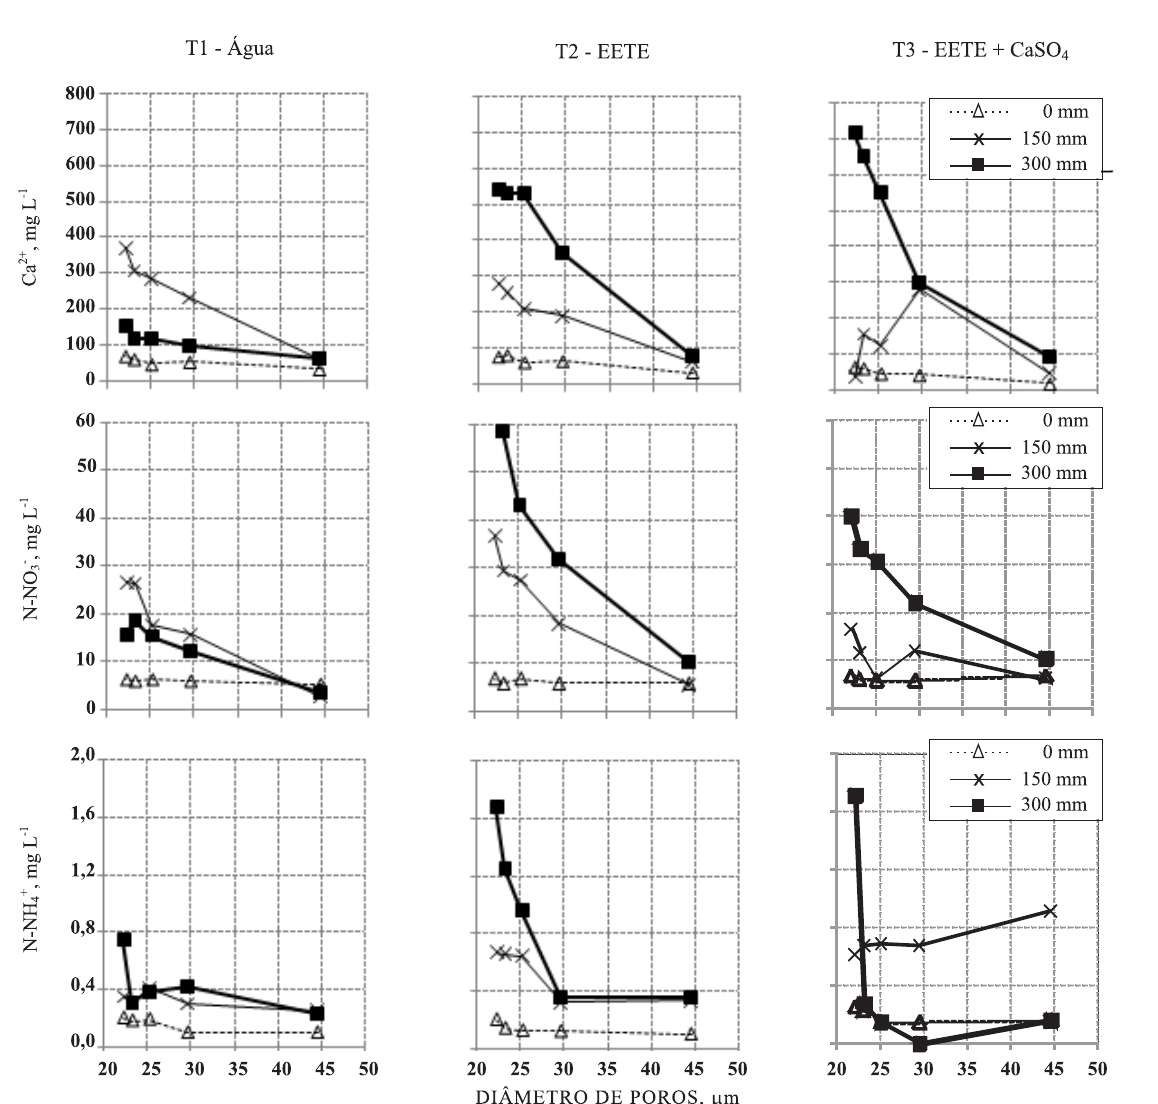
Figura 2. Valores de cálcio, nitrato e amônio na solução do solo em função do diâmetro de poro, no solo não irrigado (0 mm) e irrigado (150 e 300 mm) com água destilada (Tratamento 1), efluente de estação de tratamento de esgoto EETE (Tratamento 2) e EETE + CaSO